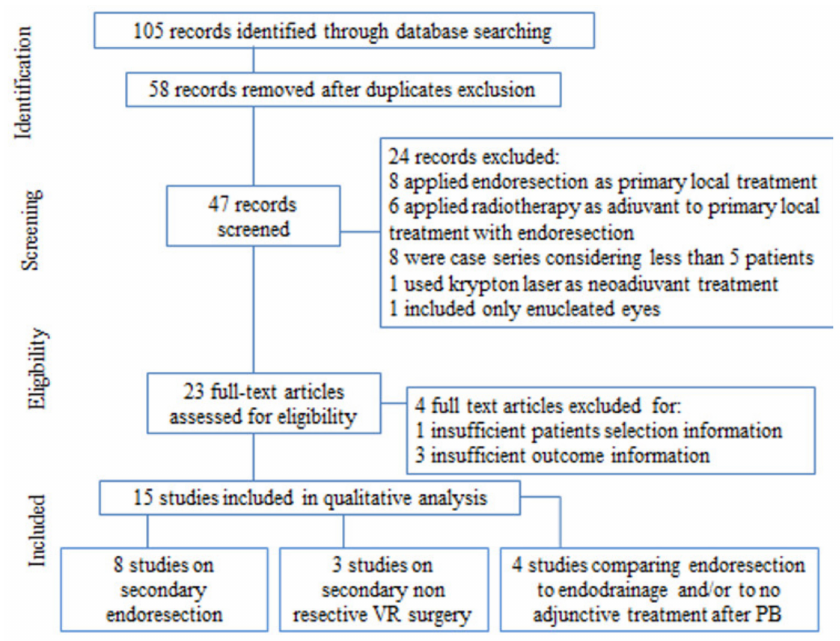
Figure 2. Visual representation of the selection process according to PRISMA